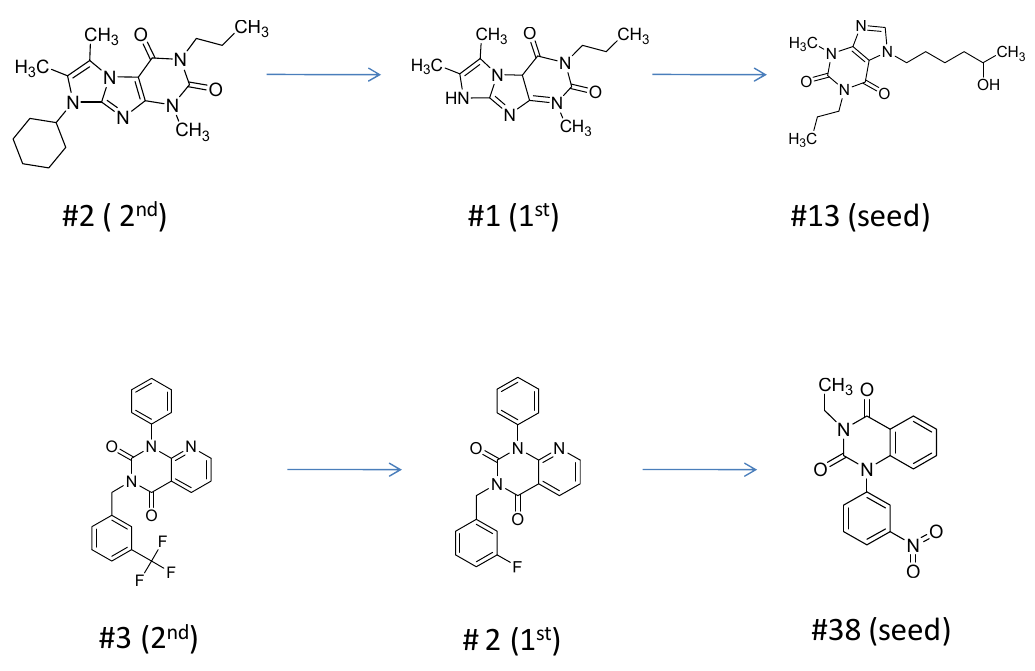
Figure 9. Hit evolution involving scaffold hopping. The hit evolution sequence of two second round hit compounds that involved scaffold hopping. #2 (2nd) → #1 (1st) → #13 (seed) (upper scheme) and #3 (2nd) → #2 (1st) → #38 (seed) (lower scheme).